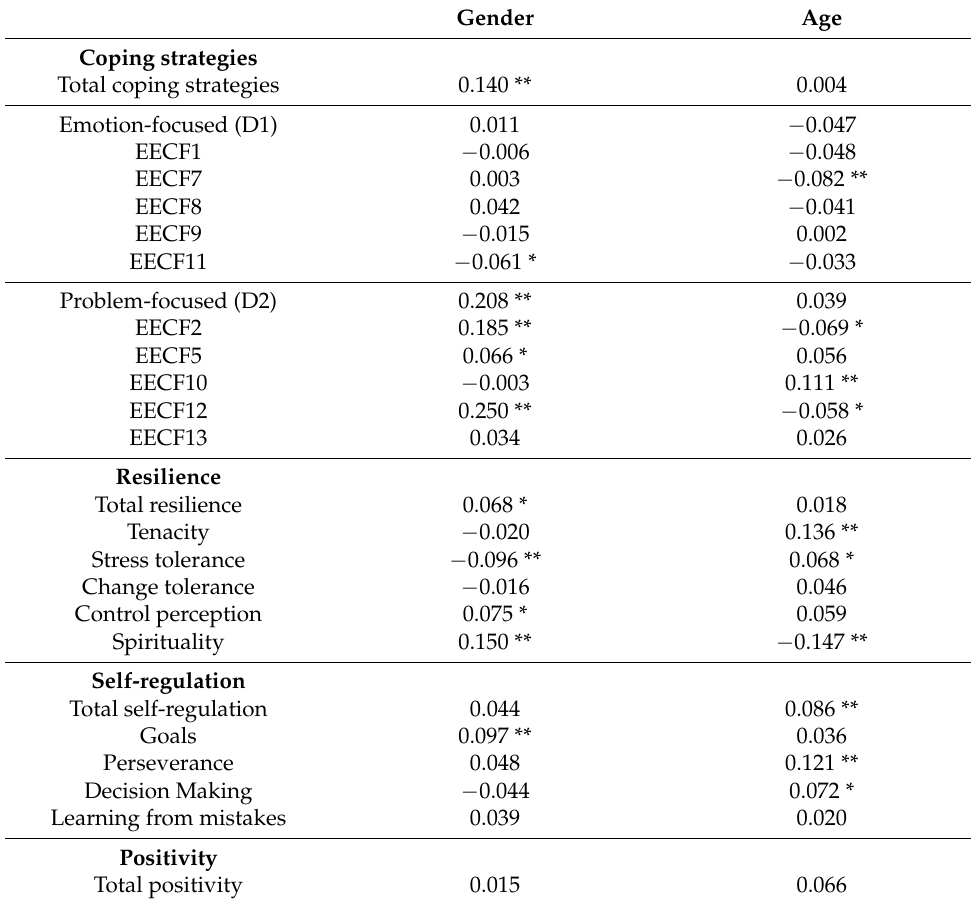
Table 4. Bivariate Correlations between Gender and Age with Well-being